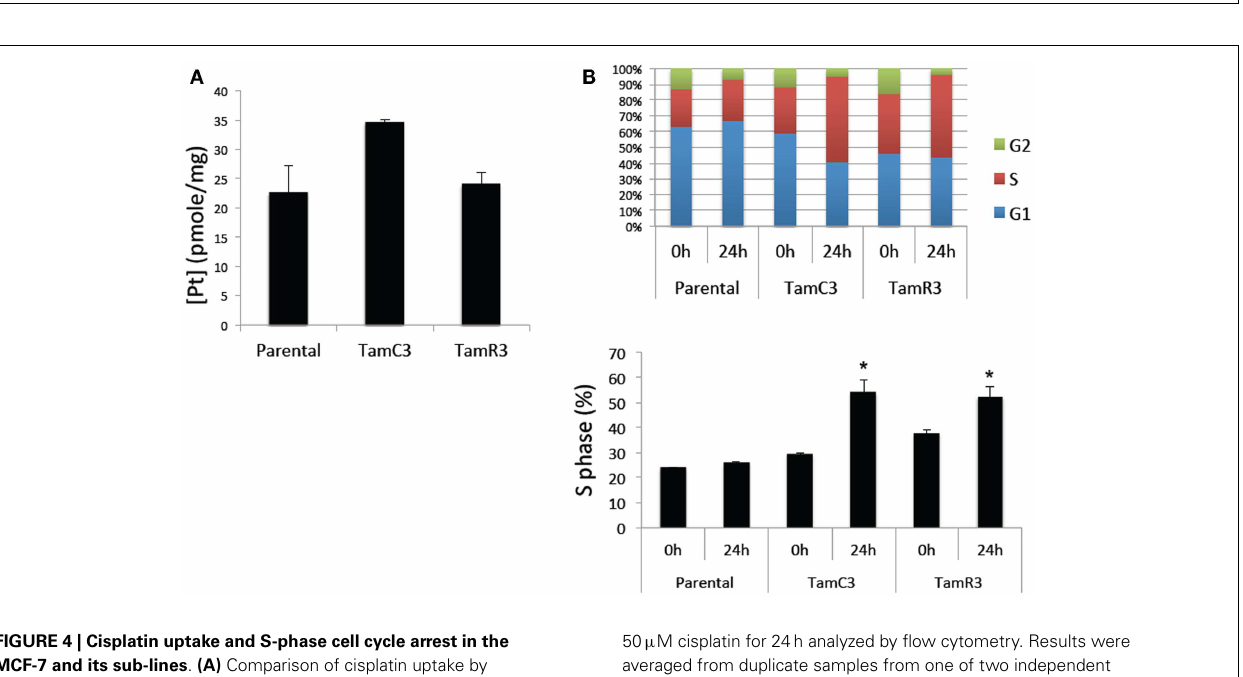
FIGURE 4 | Cisplatin uptake and S-phase cell cycle arrest in the MCF-7 and its sub-lines . (A) Comparison of cisplatin uptake by MCF-7 parental and its sub-lines. (B) Cell cycle proportions (upper panel) in S-phase (lower panel) of MCF-7 cell lines treated with